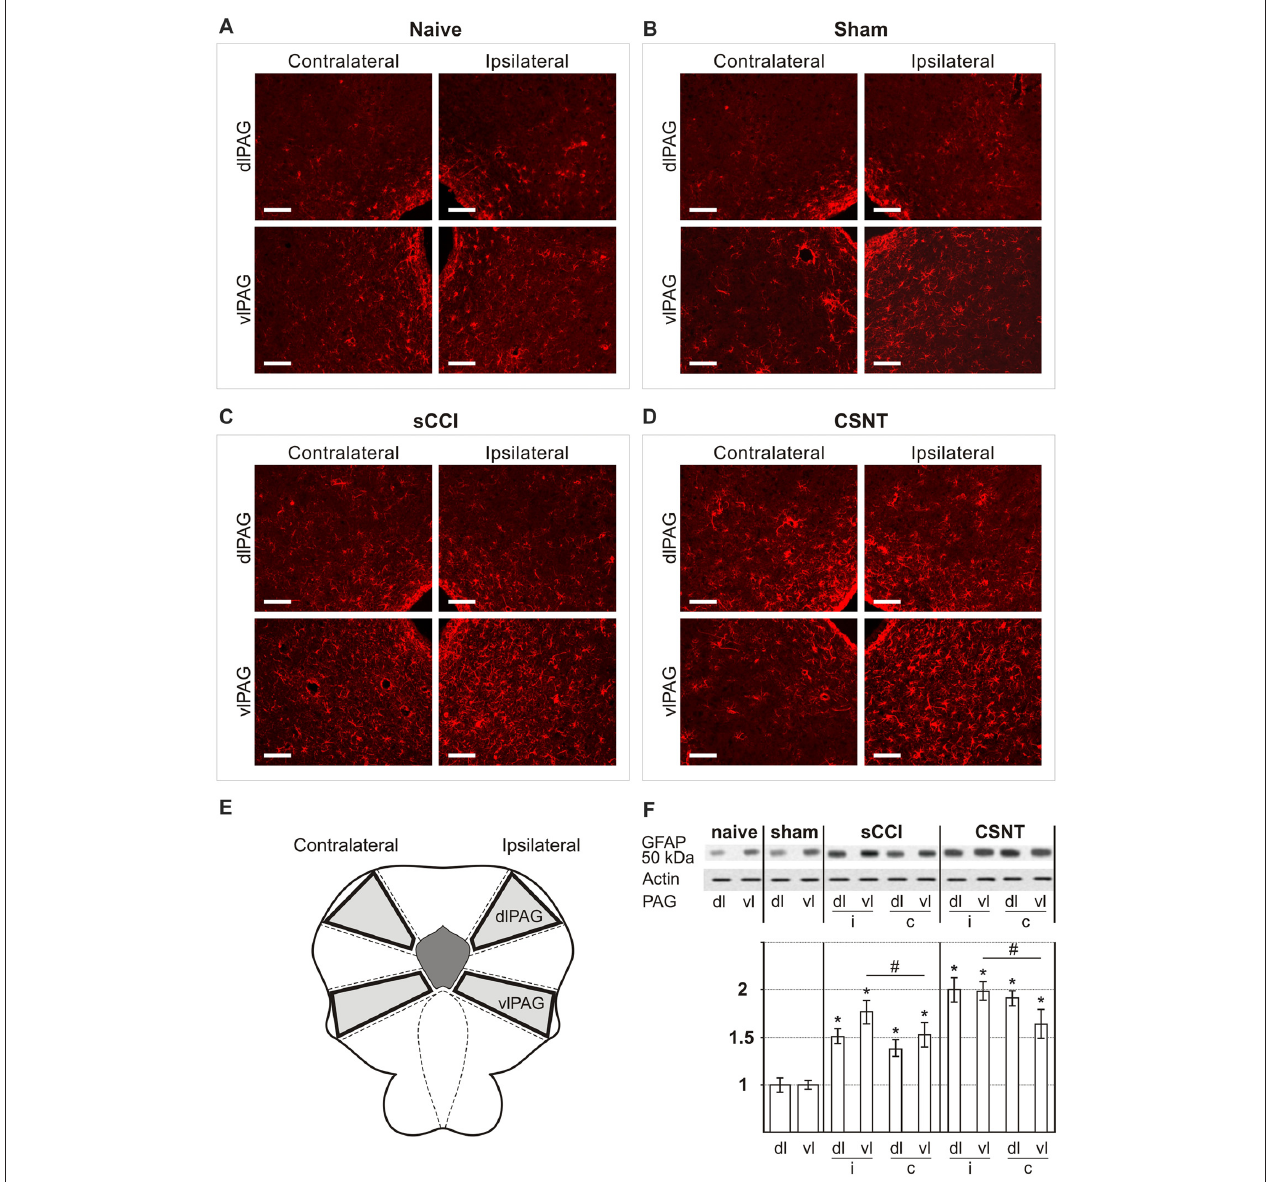
FIGURE 2 | Representative sections through dorsolateral periaqueductal gray (dlPAG) and ventrolateral PAG (vlPAG) of naïve (A) , sham- (B) , sCCI- (C) and complete sciatic nerve transection (CSNT)-operated (D) rats immunostained for glial fibrillary acidic protein (GFAP). The figures show a bilateral increase in the area containing activated GFAP+ astrocytes in both dlPAG and vlPAG after sCCI or CSNT for 3 weeks. Scale bars = 80 µ m. (E) Schematic representation of the location of dlPAG and vlPAG and their sampling for western blot analysis. (F) The top panel shows representative western blot of GFAP protein in PAG of naïve and sham-operated rats and 3 weeks after sCCI or CSNT. (i) indicates ipsilateral and (c) contralateral segments of dorsolateral (dl) and ventrolateral (vl) PAG. Graph below the blot illustrates density data obtained from three blots after normalization to actin, expressed as fold-change relative to those of sham-operated rats (set as 1). ∗ Indicates a statistically significant difference ( p < 0.05) compared to the value from sham-operated rats; # indicates a statistically significant difference ( p < 0.05) between the values from ipsilateral and contralateral